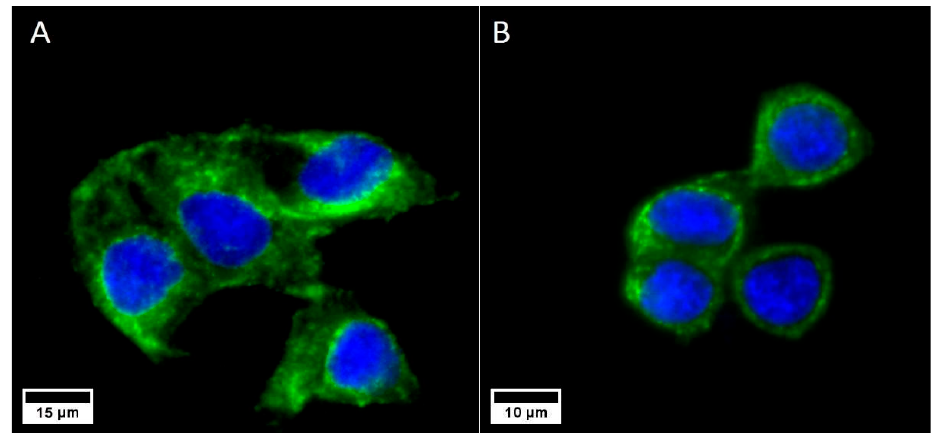
Figure 1. Caco2 cells expressing the EpCam ( A ) and SKBR3 cells expressing the TfR ( B ) receptors. In both cases, the nuclei are marked in blue (DAPI) and the cell membrane receptors are marked in green (Alexa Fluor ® 488, Abcam).